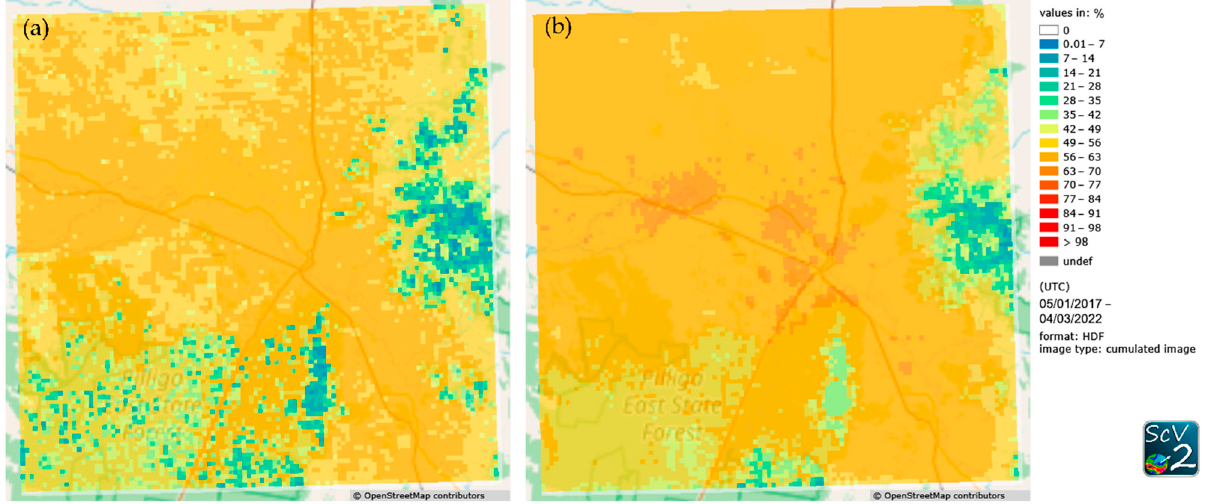
Figure 6. Data availability of soil moisture change in percent calculated as the difference between the soil moisture of consecutive days, for which soil moisture was available if the gap with no soil moisture data was shorter than five days for individual pixels ( a ). A reverse speckle filter was additionally applied to data to interpolate gaps of up to 100 pixels ( b ).